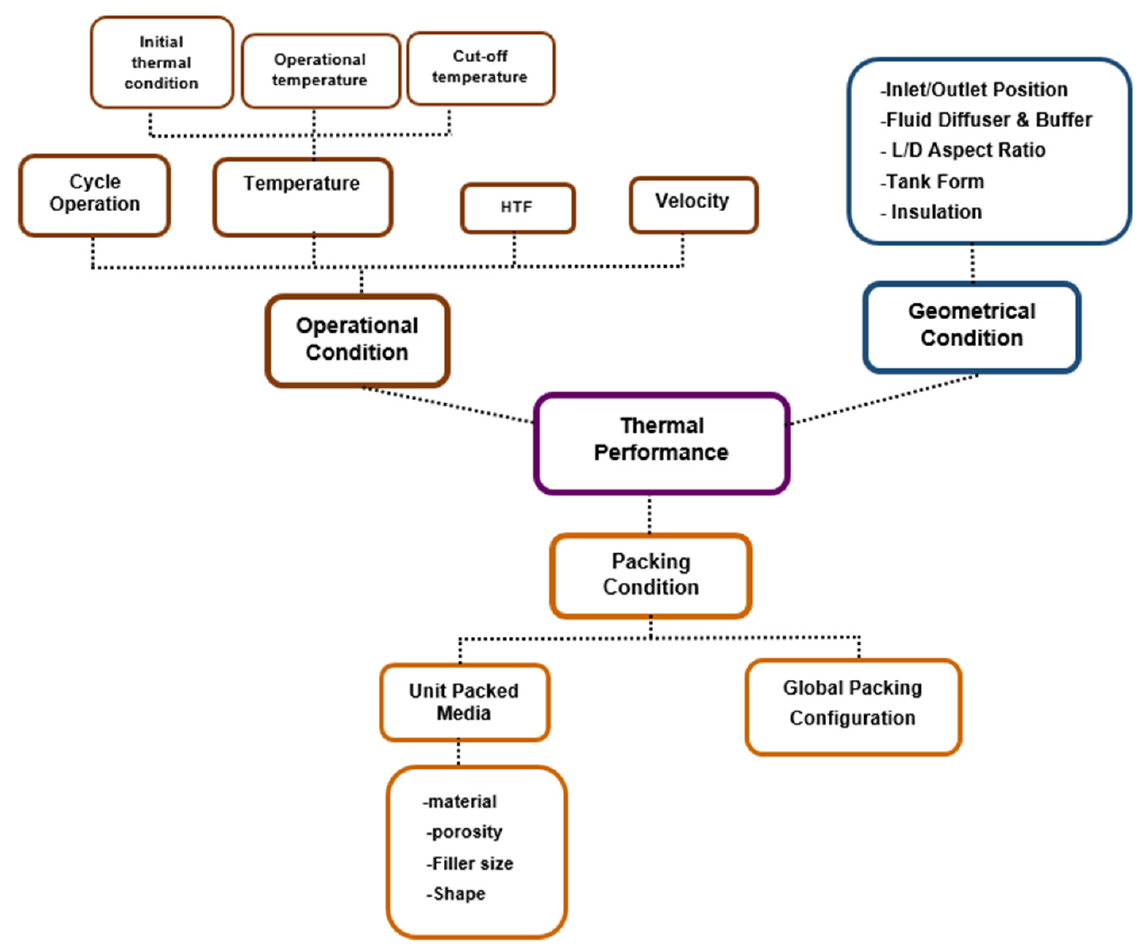
Figure 3. Schematic influencing factors (design variables) for thermocline thermal performance.